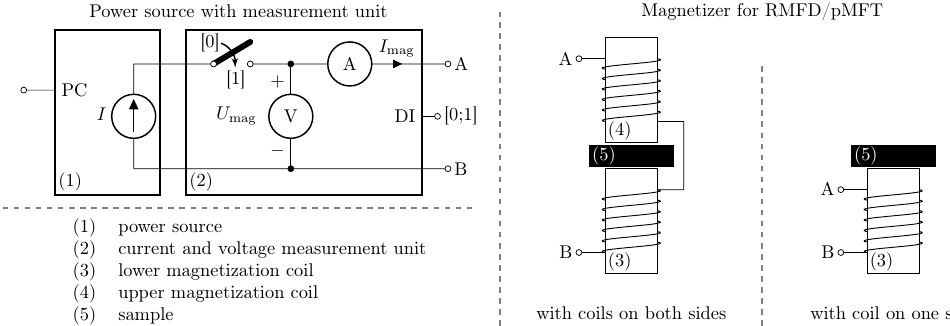
Figure 4. Schematic illustration of the modular developed test rig for measuring the magnetic properties of the materials and the welds.